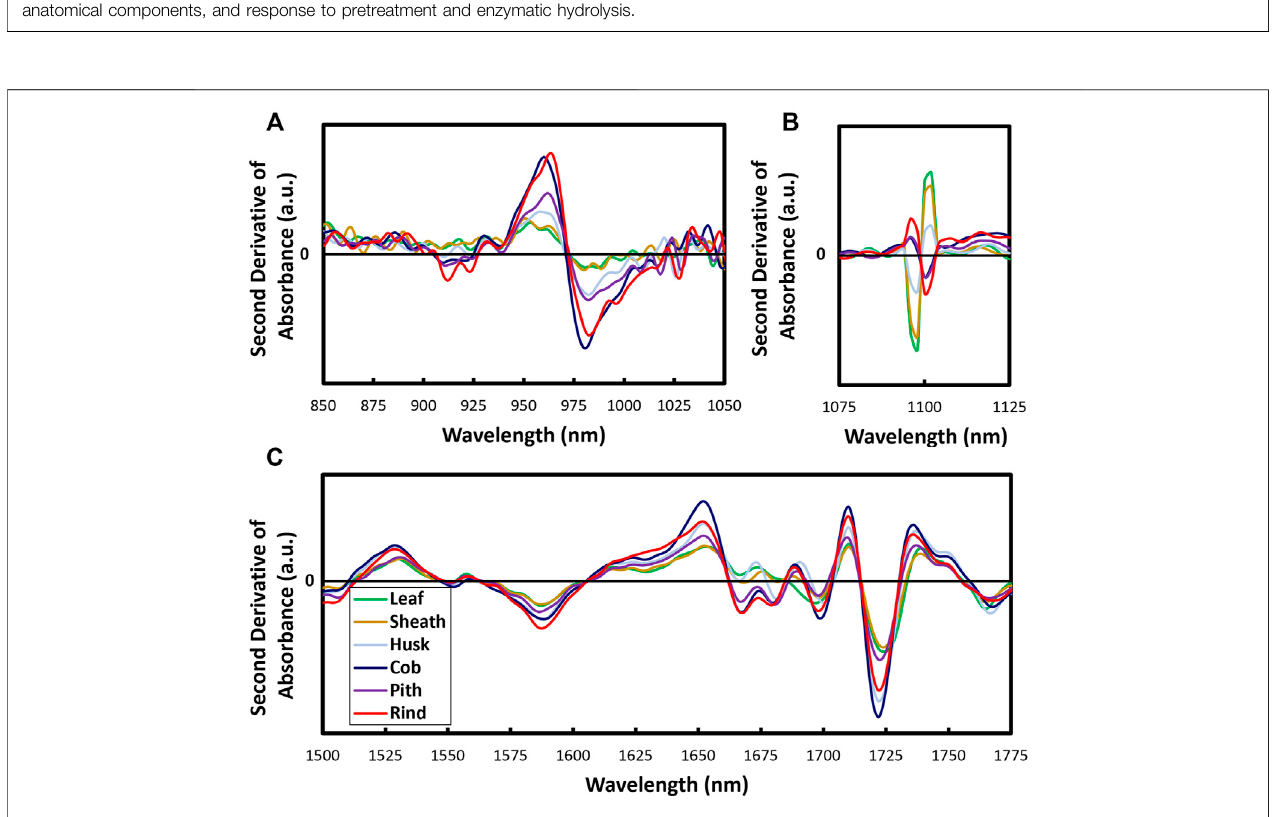
Frontiers in Energy Research |